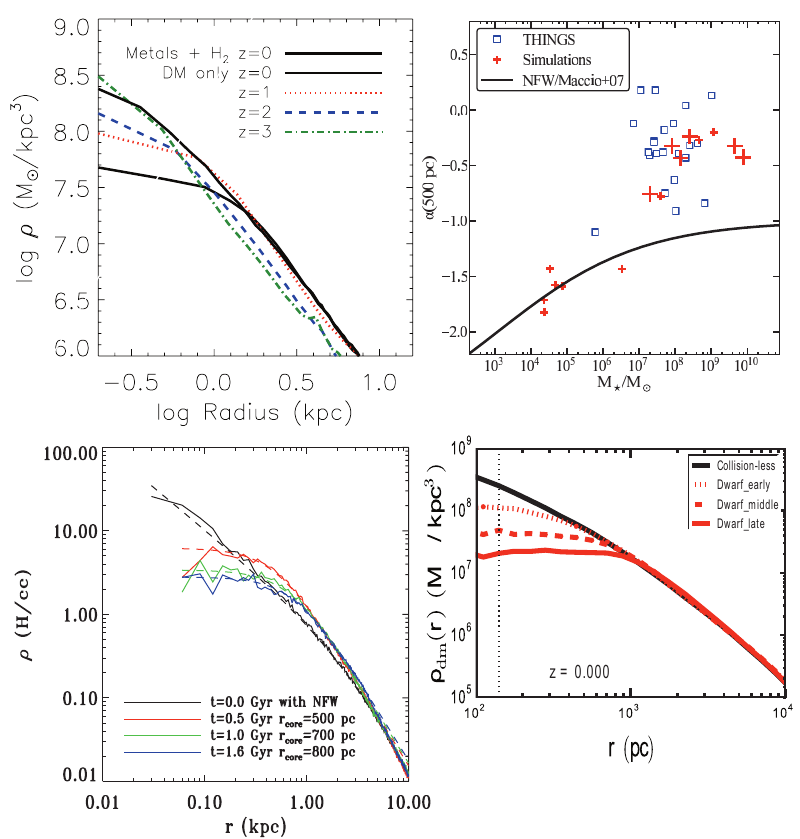
Figure 7. Effect of baryons on density profiles. The top left panel represents the evolution of a density profile in Ref. [165]’s hydrodynamic simulations. The top right panel compares their inner logarithmic slopes (at 0.5 kpc), for galaxies of different stellar mass (red crosses), with THINGS galaxies (open squares). The solid line represents the result of a previous DM-only N-body simulation [reproduced from 165]. The bottom left panel displays the density profile evolution in the hydrodynamic simulations of [289]. The bottom right panel shows the density profile evolution in the [298] hydrodynamic simulations for three different dwarfs: early (all stars form in early times), medium,